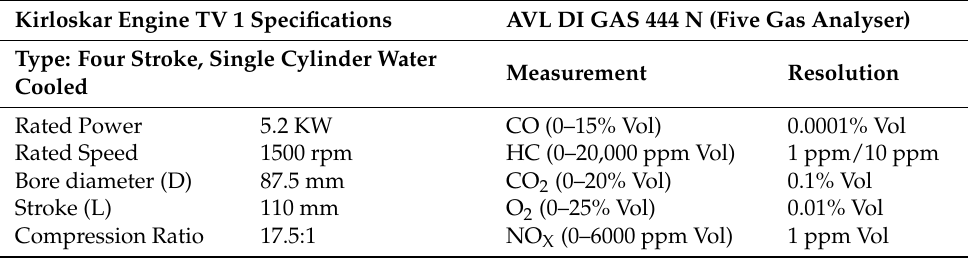
Table 1. Technical specifications of Kirloskar TV1 Engine and AVL DI GAS 444 N Flue Gas Analyzer